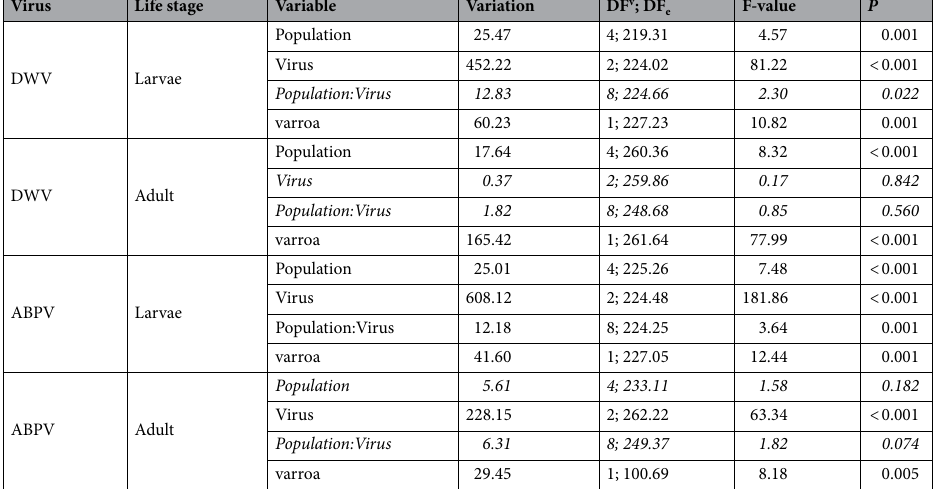
Table 1. Analysis-of-deviance tables (Type III test) for the four linear mixed models investigating the effect of honeybee population (Control, Dutch, French, Norwegian, Swedish) and inoculation treatment (DWV, ABPV, non-inoculated) on the titres of DWV and ABPV in larvae and adults. Non-significant terms (italicized) were removed stepwise, starting with the Population:Virus interaction term, until the final minimal adequate model was obtained. Indicated are the Virus studied; the bee Life stage investigated in the inoculation time- course; the explanatory Variable analysed ( Virus inoculation treatment; honeybee Population of origin; their Population:Virus interaction and the effect of the colony-level phoretic varroa infestation rate for each colony (see Supplementary Fig. 3 for the direction of the effect)); the variation for each variable; the Degrees of Freedom associated with the target variable ( DF v ) and the combined error variance ( DF e ), derived from the replicate colonies and the multiple post-inoculation sampling time-points; the F-value representing the ratio between the target MS and the error variance, and the probability ( P ) of obtaining this F-value by chance, given the DF v and DF e . Significance was set at p < 0.01, with non-significant items shown in